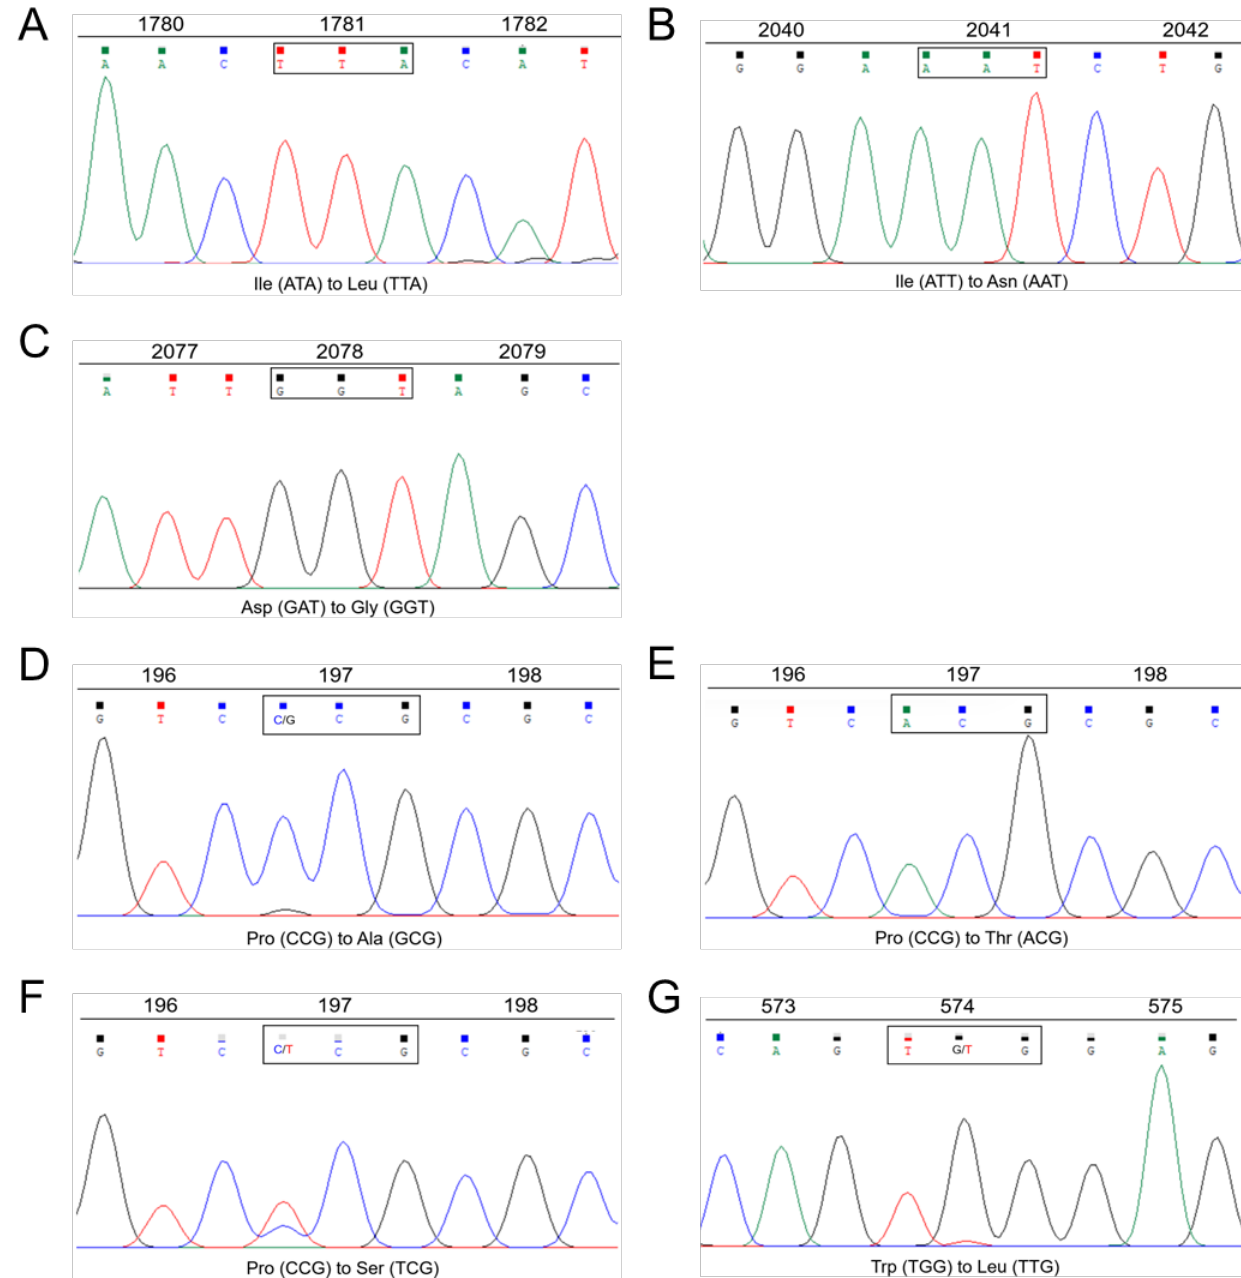
Figure 2. Partial ACCase and ALS gene sequences from different resistant populations of L. multiflorum . ACCase sequences showing ( A ) Ile-1781-Leu, ( B ) Ile-2041-Asn, and ( C ) Asp-2078-Gly mutations. ALS sequences showing ( D ) Pro-197-Ala, ( E ) Pro-197-Thr, ( F ) Pro-197-Ser, and ( G ) Trp-574-Leu mutations.